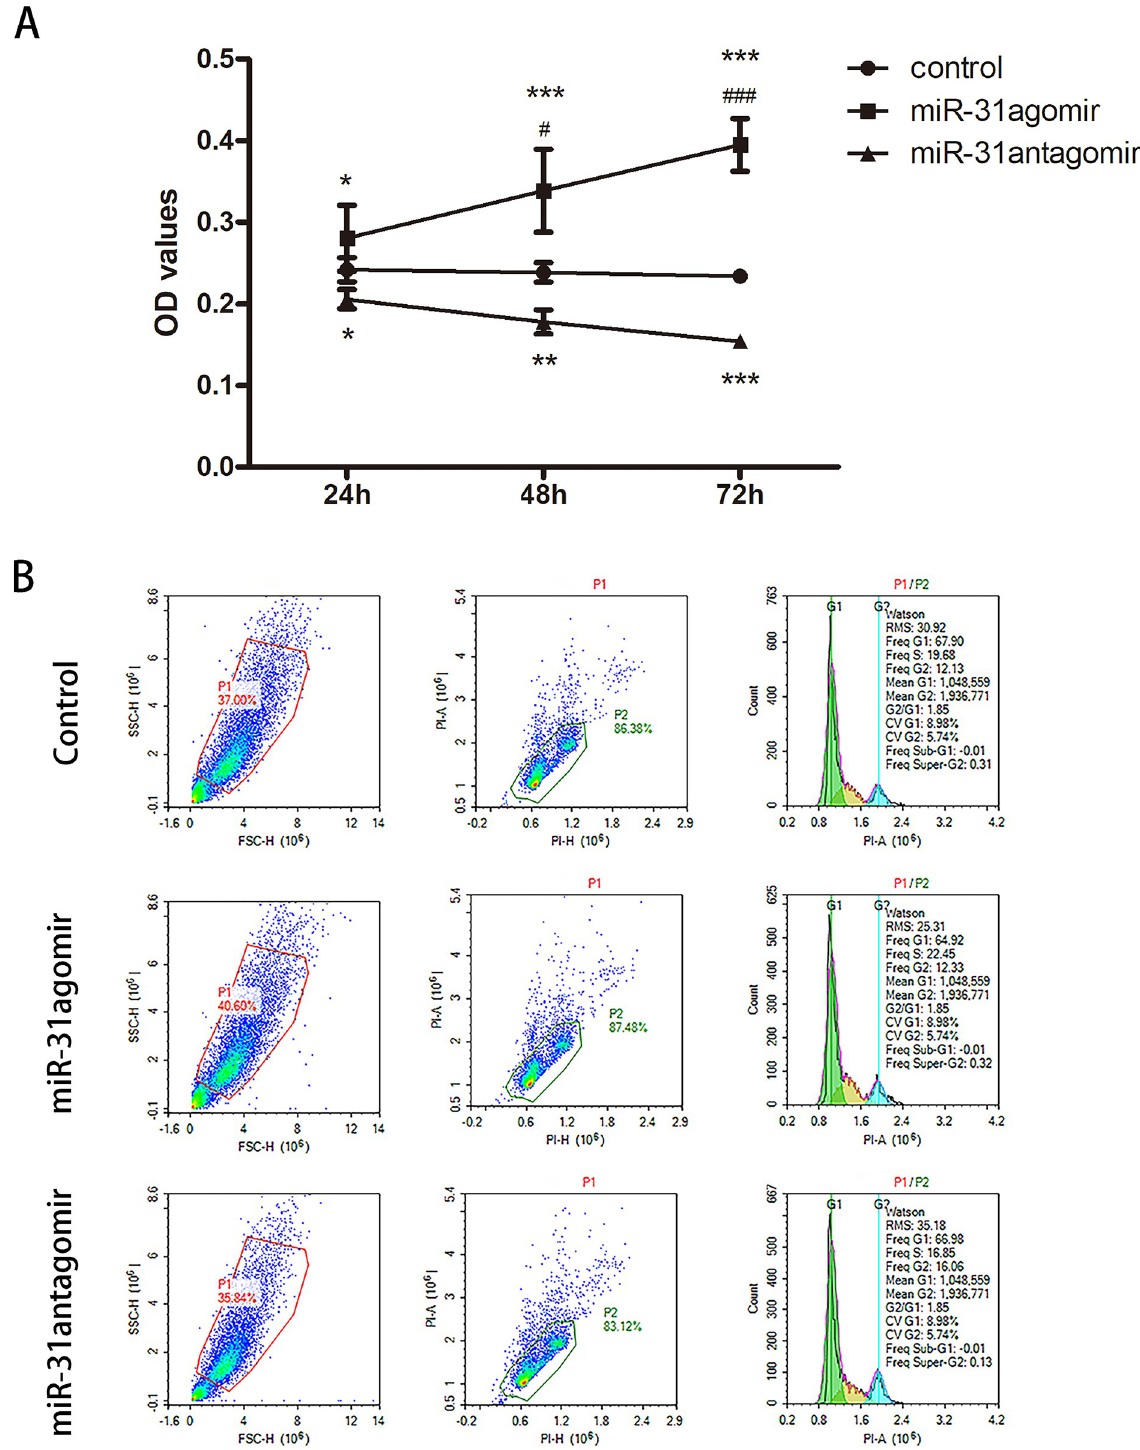
Fig 3. Effect of miR-31 on BMSCs proliferation. A To analyze the effect of miR-31 on the proliferation of BMSCs. The OD values of miR- 31 agomir, miR-31 antagomir and control at 450m for 24, 48 and 72 hours were detected by CCK-8. B Detection of the cell cycle distribution of each group of cells by flow cytometry. Dates are presented as mean ± SD (n = 5). Statistical analysis: within group compared to control, � P < 0.05, �� P < 0.01, ��� P < 0.001; between groups compared to 24 hours miR-31 agomir, # P < 0.05, ### P < 0.001.